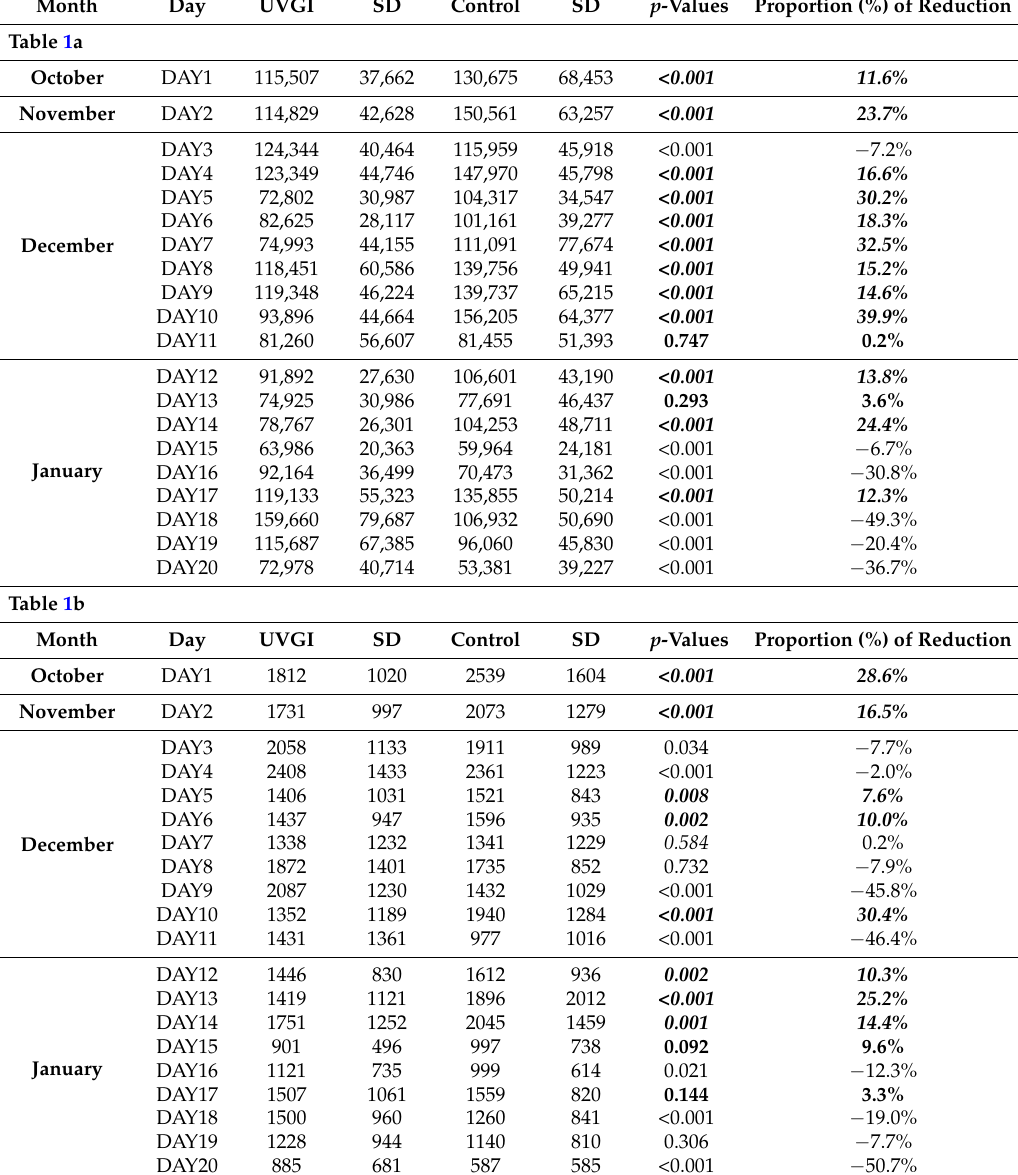
Table 1. Daily average fluorescent bioaerosol count (FBC) ( a ) fine size A (<3 µ m), and ( b ) coarse size (10 µ